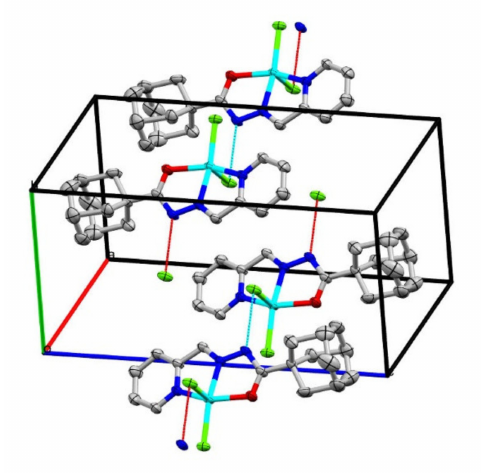
Figure 7. Packing diagram along c-axis showing the intermolecular interactions in 1 , the hydrogen atoms, disorder in adamantly and crystallization solvents were excluded for clarity